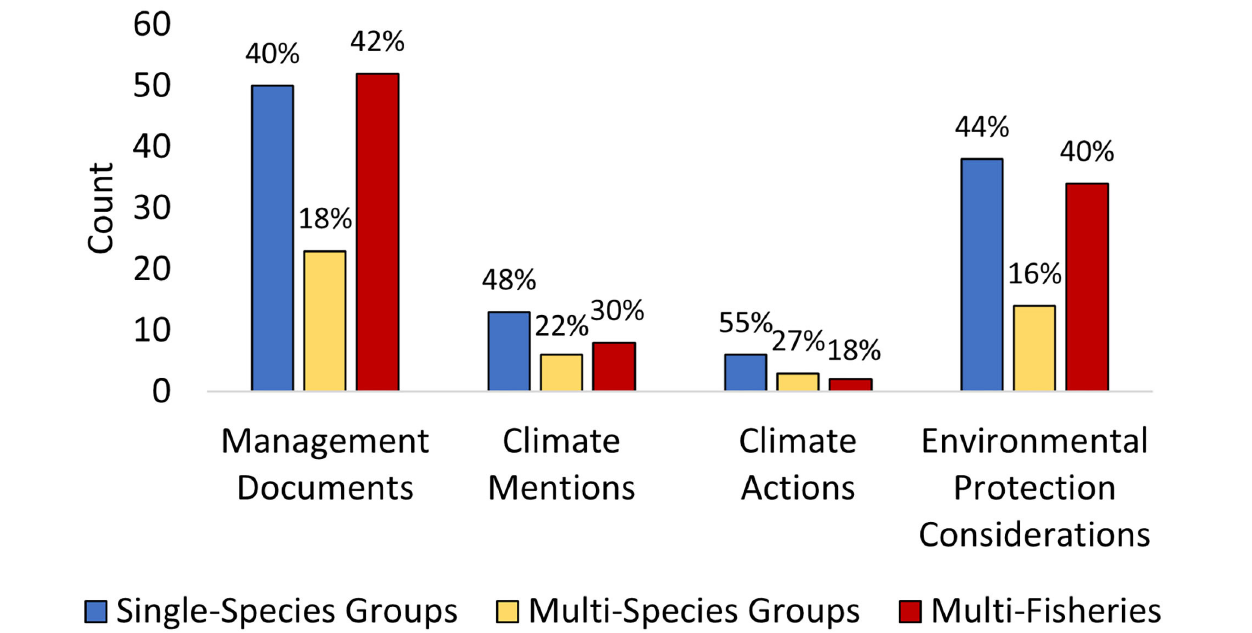
these five Single-Species Groups were also among the top six Single-Species Groups with the highest Commercial Catch Weights (i.e., Catch Weights ranking order: 1. Sardines ,